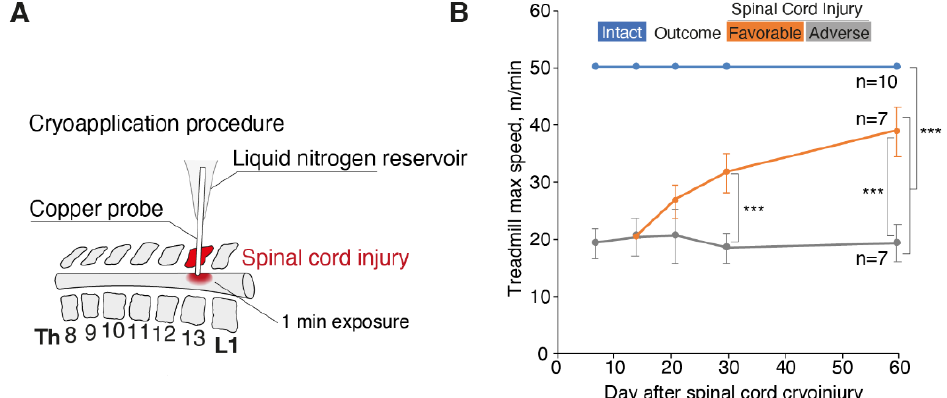
Figure 1. Motor activity of the animals with spinal cord cryoinjury in the groups with favorable and adverse outcomes. ( A ) Spinal cord cryoinjury technique. ( B ) Maximal animal speed (m/min) on a treadmill in groups with favorable and adverse outcomes in comparison with intact animals. Bars represent standard deviation, the p < 0.001 (***) values according to the Mann–Whitney test are indicated.